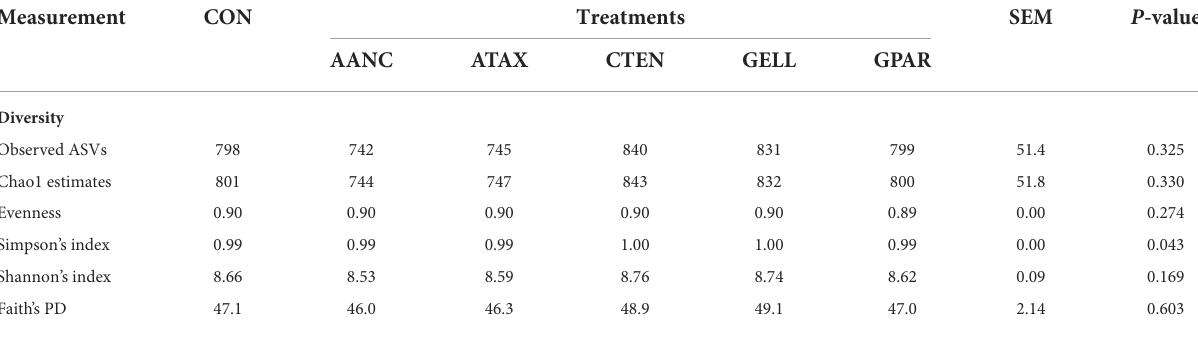
TABLE 2 Alpha diversity measurements of the microbiota 24h of in vitro